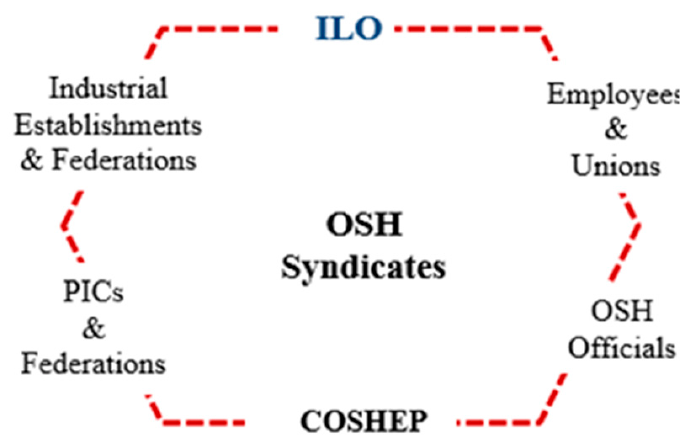
Figure 25. The structure of the proposed OSH syndicates, where: COSHEP = The Palestinian National Center of Occupational Safety, Health, and Environmental Protection, PICs = Palestinian Insurance Companies, ILO = International Labor Organization.